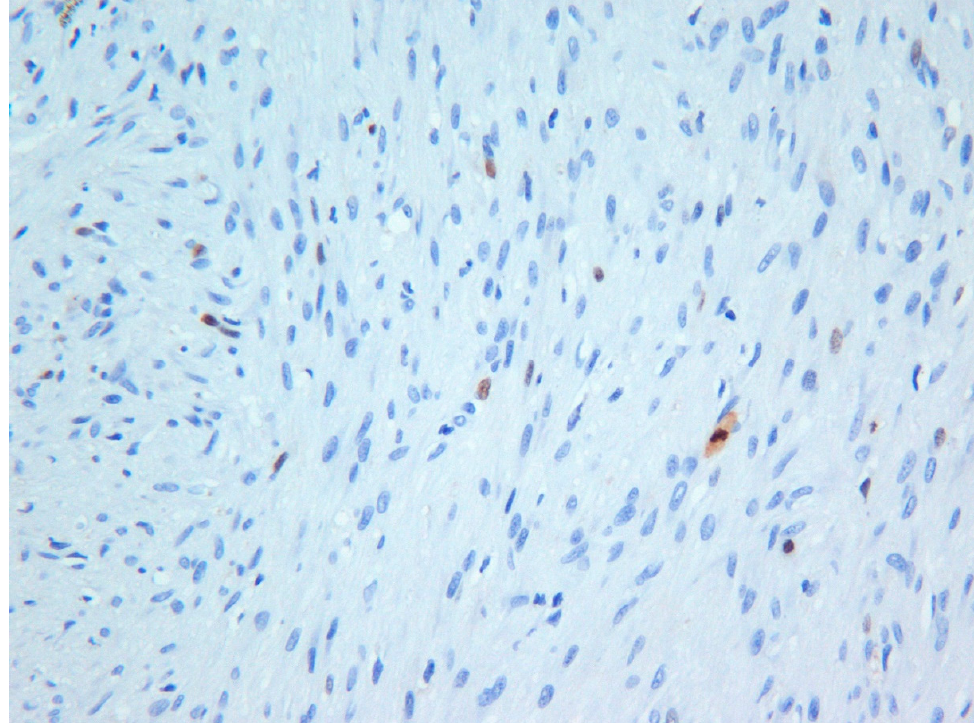
Figure 4. Photomicrograph exhibiting low Ki-67 (MIB-1) activity in the tumor—Case 3 (×20).